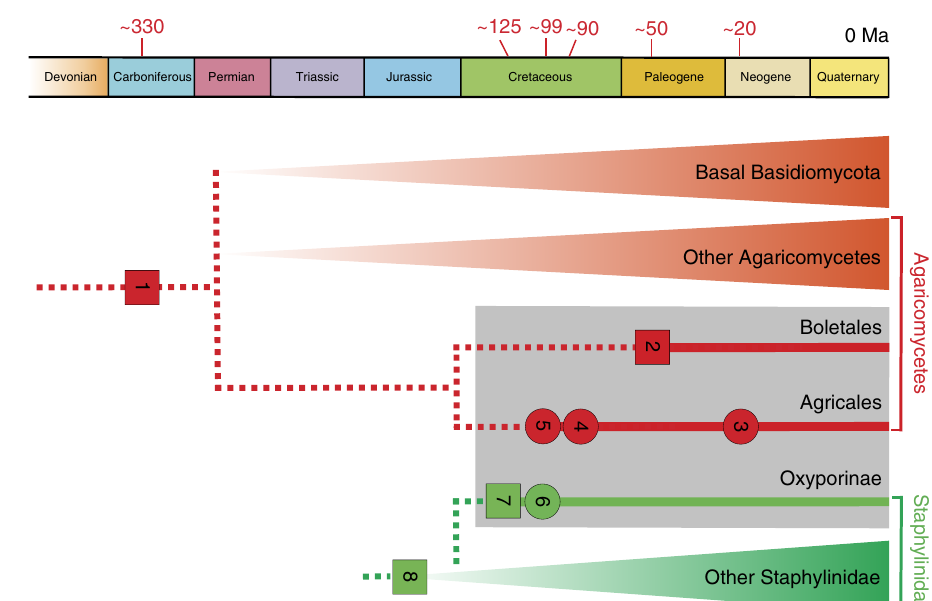
Figure 4 | Associations of higher Agaricomycetes and specialized oxyporine Staphylinidae. Framework for Basidiomycota (red part) based on Taylor and Berbee 31 , Floudas et al. 36 and Hibbett et al. 37 1: Oldest basidiomycete clamp connections from late Visean (Mississippian, B 330Myr) of France 38 ; 2: oldest Boletales (Ectomycorrhizae) from middle Eocene ( B 50Myr) Princeton chert of British Columbia 39 ; 3: modern-appearing mushrooms from Miocene ( B 20Myr) Dominican amber 3 (cid:2) 5 ; 4: mushrooms from the Late Cretaceous ( B 90Myr) New Jersey amber 1,3 ; 5: diverse mushrooms from mid-Cretaceous ( B 99Myr) Burmese amber; 6: diverse obligately mycophagous Oxyporinae from mid-Cretaceous Burmese amber; 7: diverse Oxyporinae from the Early Cretaceous Yixian Formation ( B 125Myr) of China 1 ; 8: oldest known Staphylinidae from the Middle Jurassic (Aalenian (cid:2) Bathonian) of Kubekovo, Russia 40 . Squares, compression fossils. Circles, amber